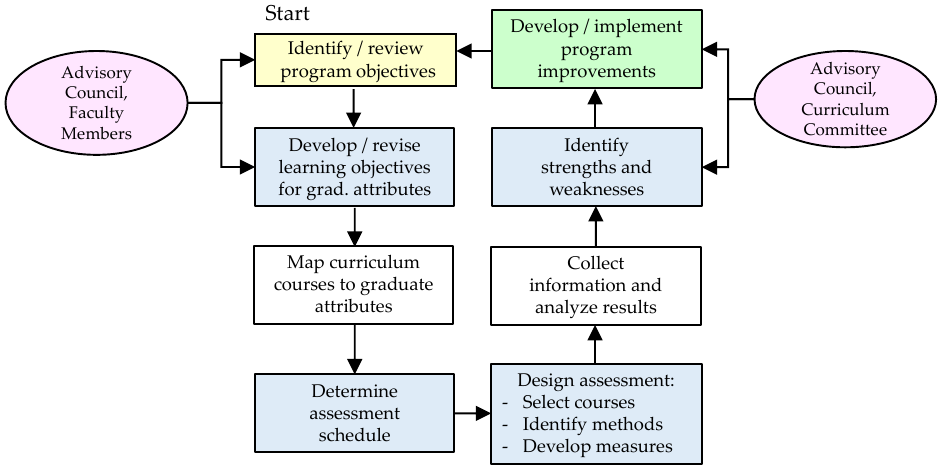
Figure 6. Typical process of graduate-attribute assessment (faculty-level activities are shaded in blue)